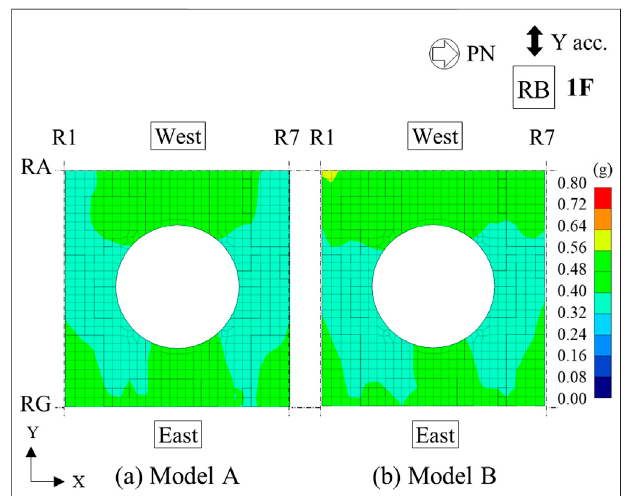
FIGURE 11 | Maximum acceleration contours in EW direction for